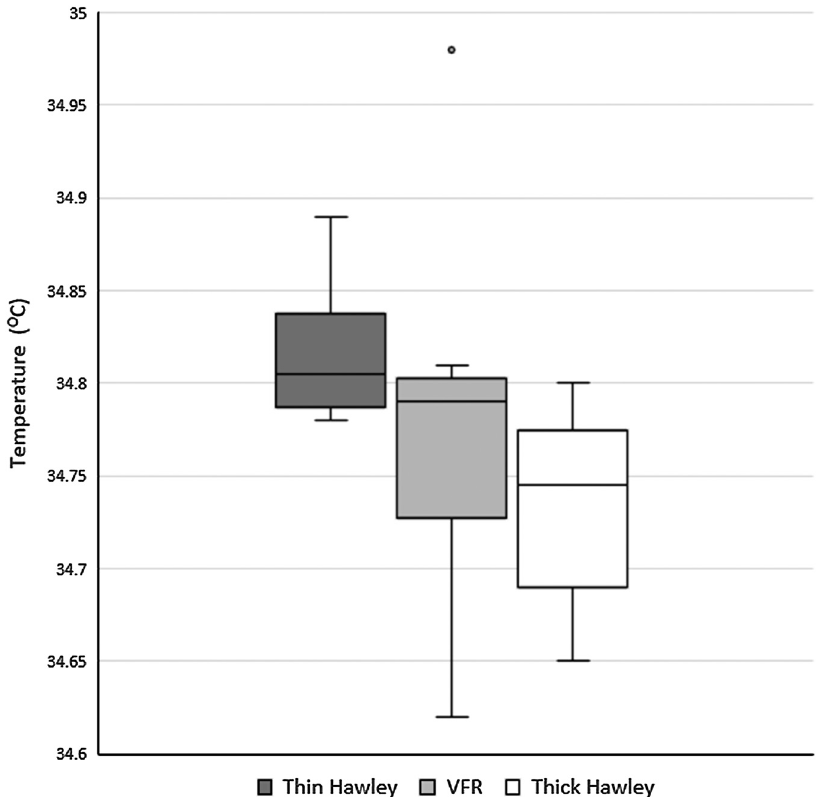
Figure 4. Distribution of microsensor temperature readings within each